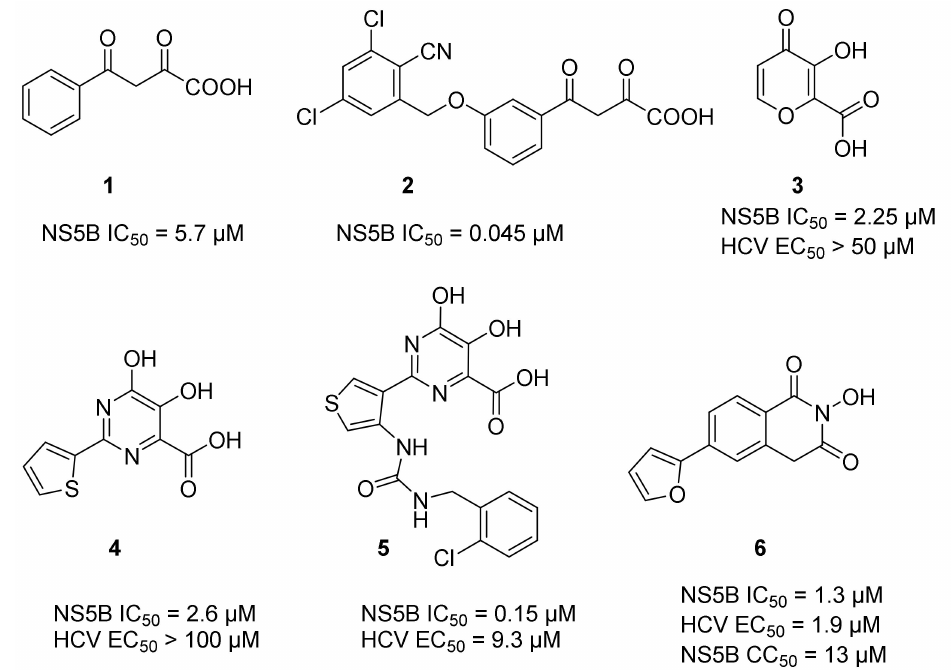
Figure 1. A series of representative non-structural protein 5B (NS5B) metal ion